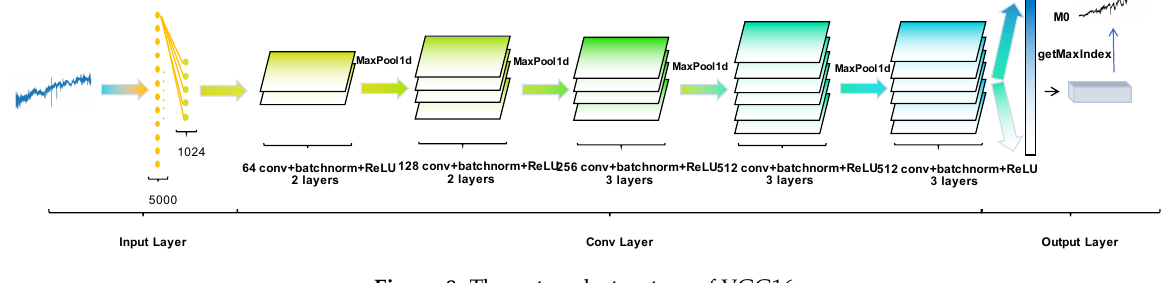
Figure 8. The network structure of